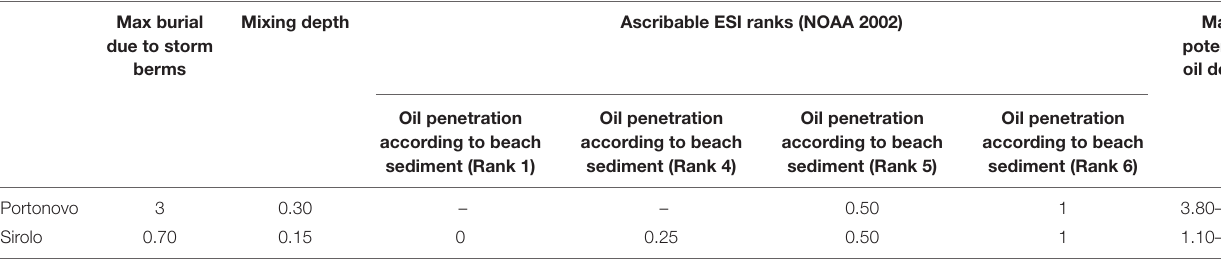
FIGURE 6 | Wave dataset from March 2012 to February 2014. The topographic surveys and sampling are also marked for both beaches. TABLE 6 | Estimation of the max potential depth that oil can reach in the case of an oil spill event in Portonovo and